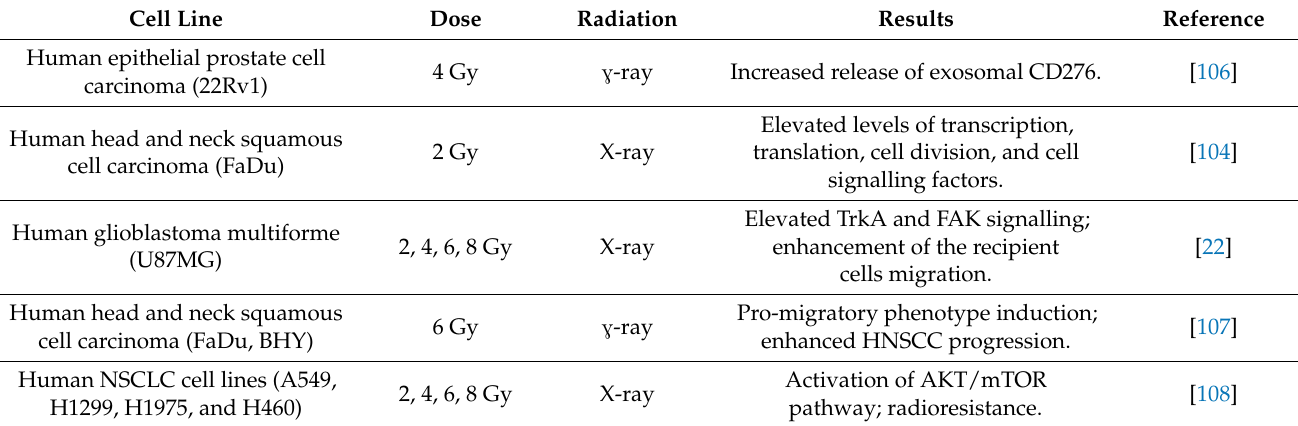
Table 1. Influence of the ionising radiation on exosomes’ characteristics from different cell